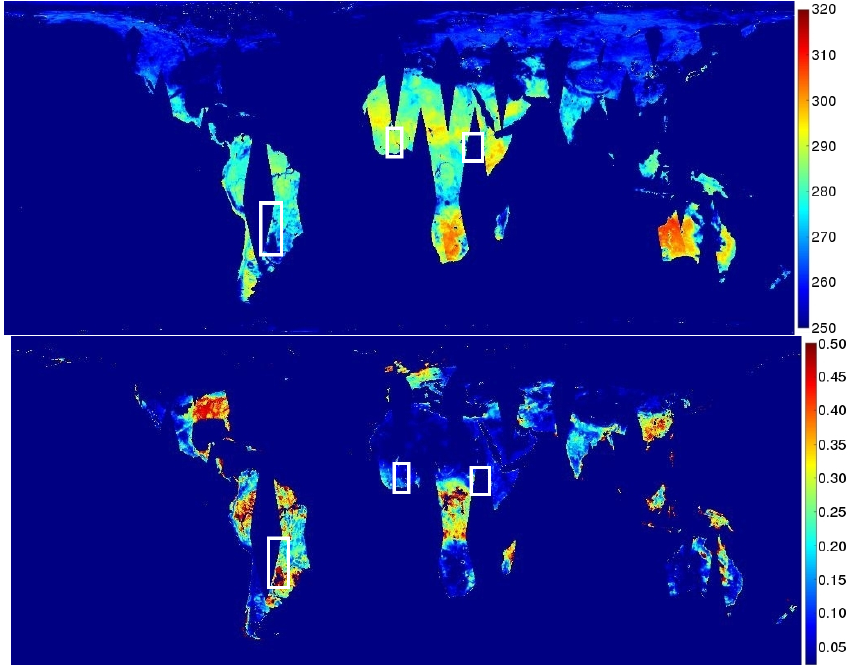
Figure 3. Nine kilometer pixel resolution examples of a global map of the v-pol SMAP brightness temperature ( top ) and derived soil moisture ( bottom ) for day 2 of 2016. The brightness temperature is reported in Kelvin, and the soil moisture is reported in cm 3 cm − 3 . The white boxes show the locations of the study areas in Figures 1, 4, and